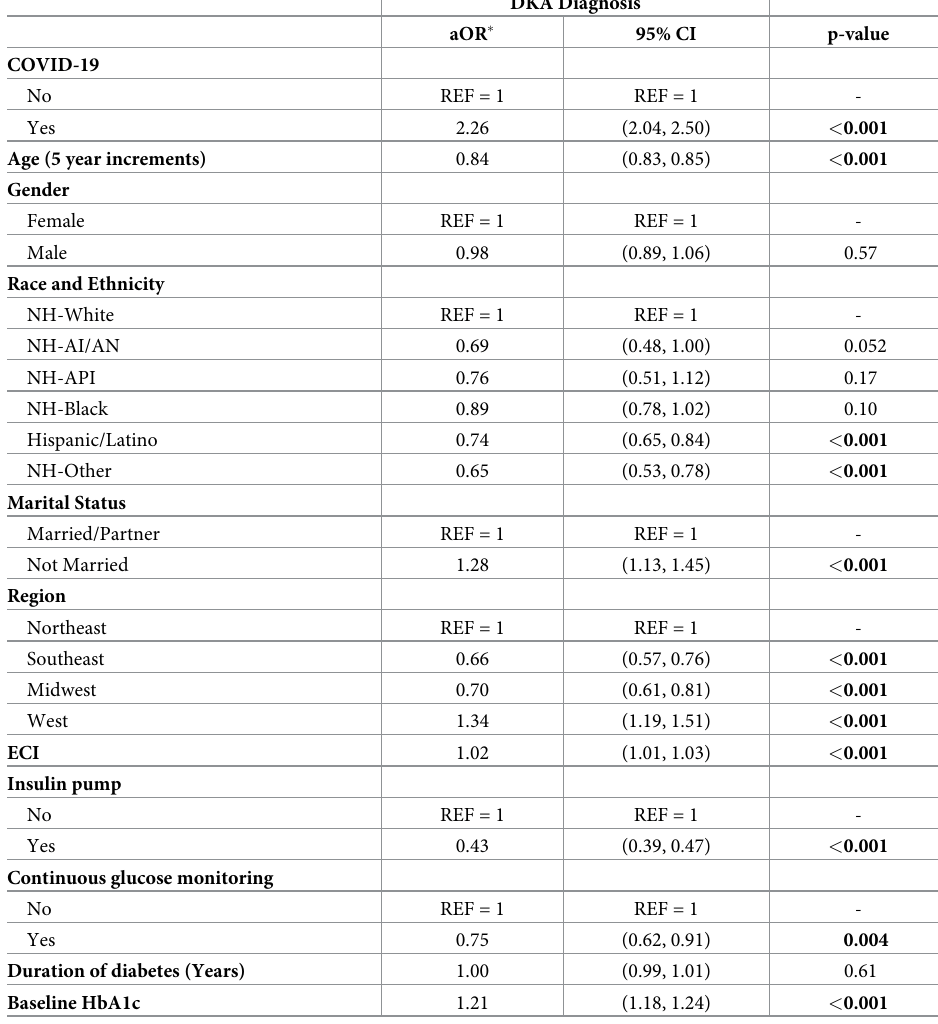
Table 4. Adjusted associations of COVID-19 diagnosis with incidence of DKA among patients with previous T1D